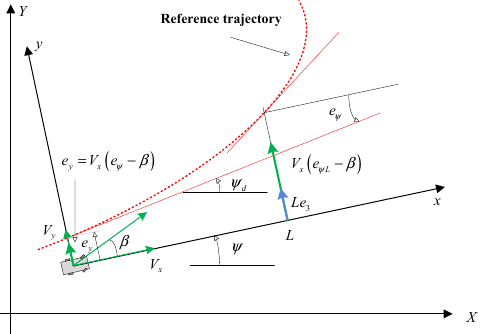
Figure 2. Lateral position and velocity errors at the look-ahead distance